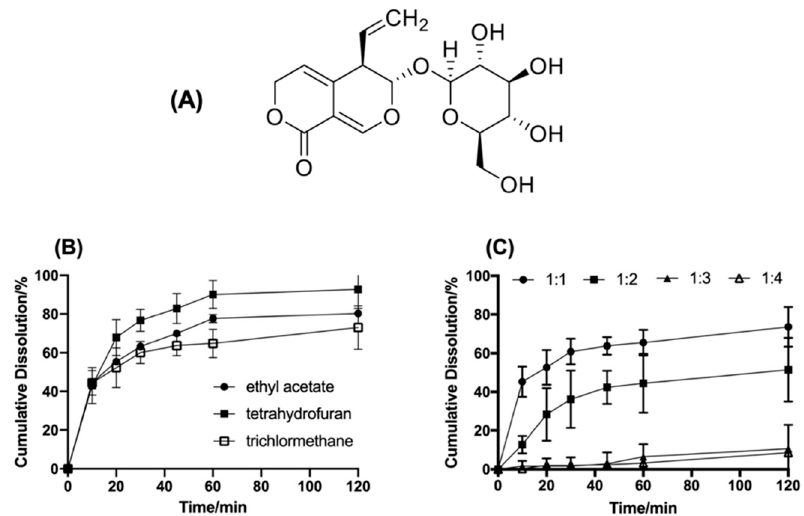
Figure 1. The structure of GTP and its influencing factors on the formation of phospholipid com- plexes. ( A ): The structure of GTP. ( B ): Cumulative Dissolution of phytosome of different type of solvent in phosphate buffer saline (pH 6.8). ( C ): Cumulative Dissolution of phytosome of different molar ratios of GTP and phospholipids.